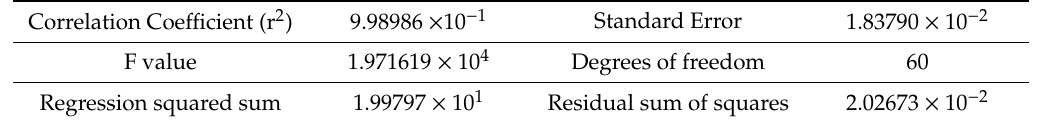
Table 5. Linear regression